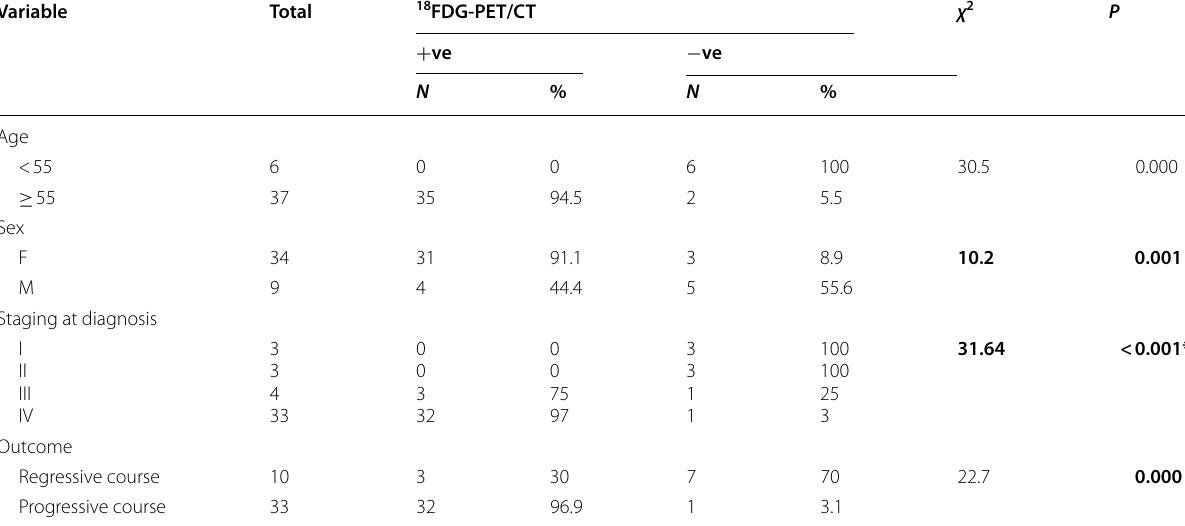
Table 2 Relation between positivity of 18 FDG-PET/CT and age, sex, DTC staging and outcome